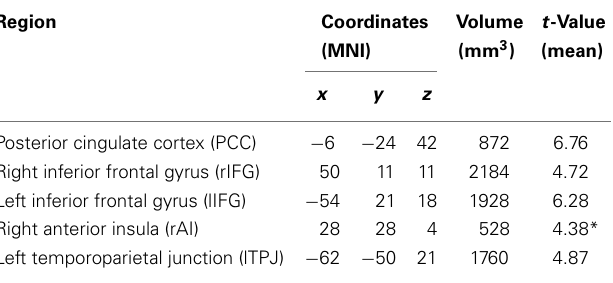
Table 2 | Experiment 1 (supplemental) regions of interest identified by activation for [SON − 0.5 (FN + UN)] across EO and